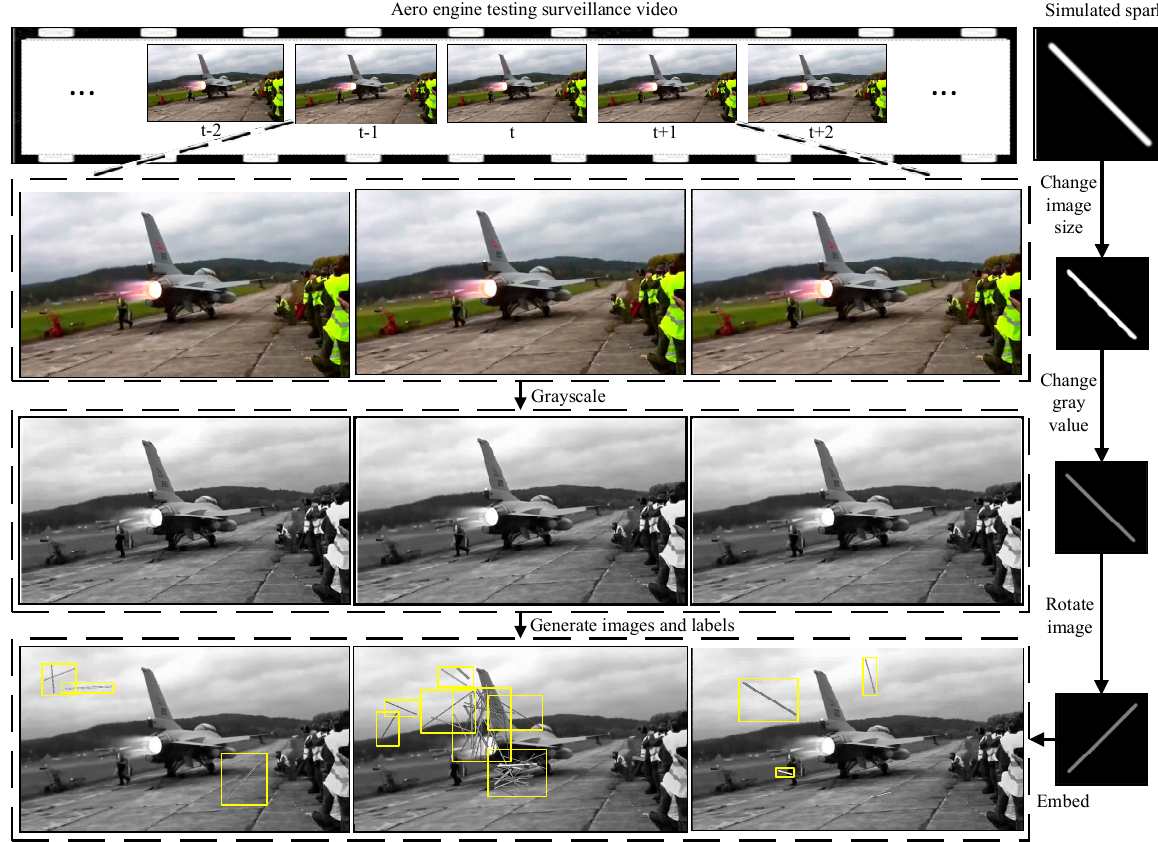
Figure 11. The schemaic digram of adding gray images of Gaussian-generated sparks to normal engine images and generating corresponding labels.